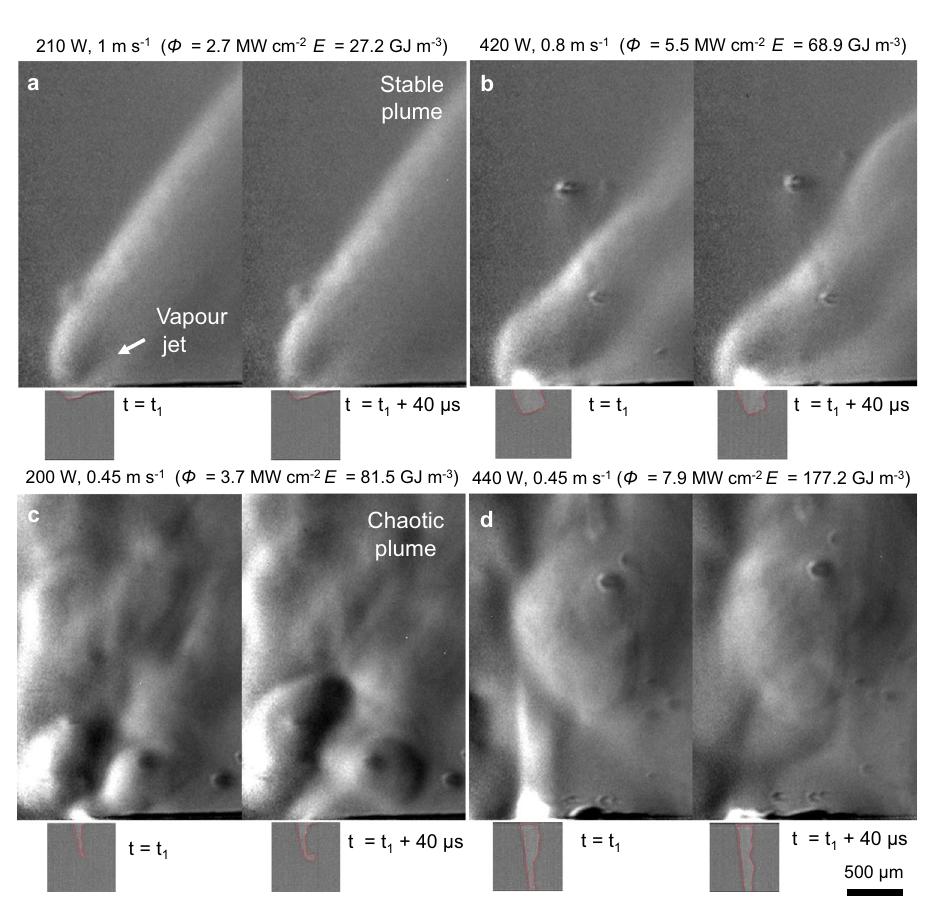
Fig. 4 Visualisation of the Ti – 6Al – 4V substrate only (no powder) and Ar atmosphere during scanning of single lines with varying input energy densities. The outline of the keyhole boundary is highlighted in red in the x-ray images, which are at the same scale as the schlieren image. a Under low energy input, the depression ’ s shape remains constant and a steady vapour jet emitted from the irradiated surface results in a steady plume. b For E < 70 GJ m − 3 the depression remains at stage II, where small fl uctuations in the LVI perturb the plume but the fl ow pattern remains. c – d High input energy density due to ( c ) low scanning speed or ( d ) high power density result in stage III depressions with chaotic plumes. A video with the images used in this fi gure is available in the supplementary